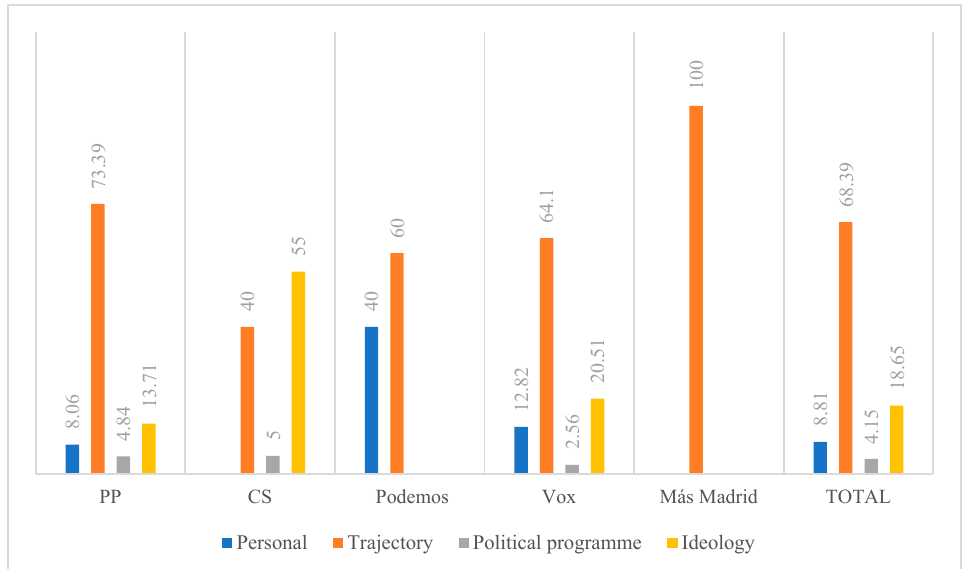
Figure 3. Typology of criticism in Telegram messages from political parties (% within the user). Source: Self-made.